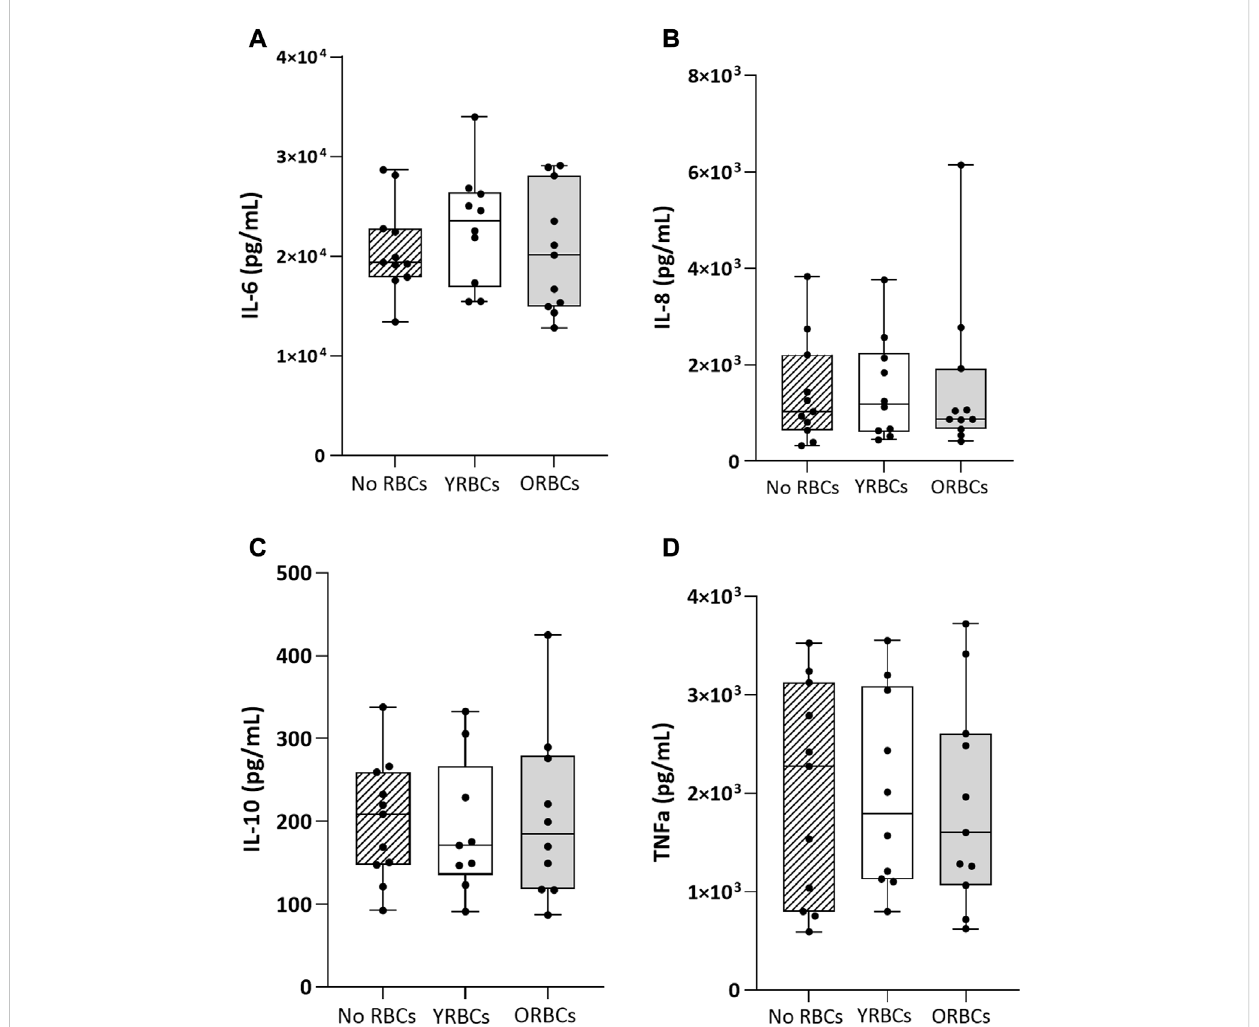
FIGURE 5 Cytokine levels after whole blood stimulation in presence or absence of young red blood cells (YRBCs) or old red blood cells (ORBCs). Concentrations of (A) IL-6, (B) IL-8 (C) IL-10, and (D) TNF α were measured after stimulating whole blood with LPS. n = 9 – 11